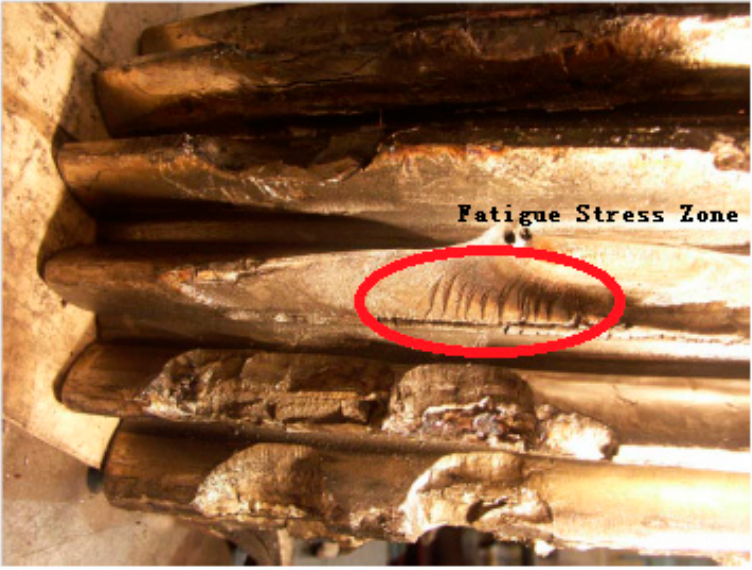
Figure 16. WT gearbox sun gear of planetary stage teeth broken failure.